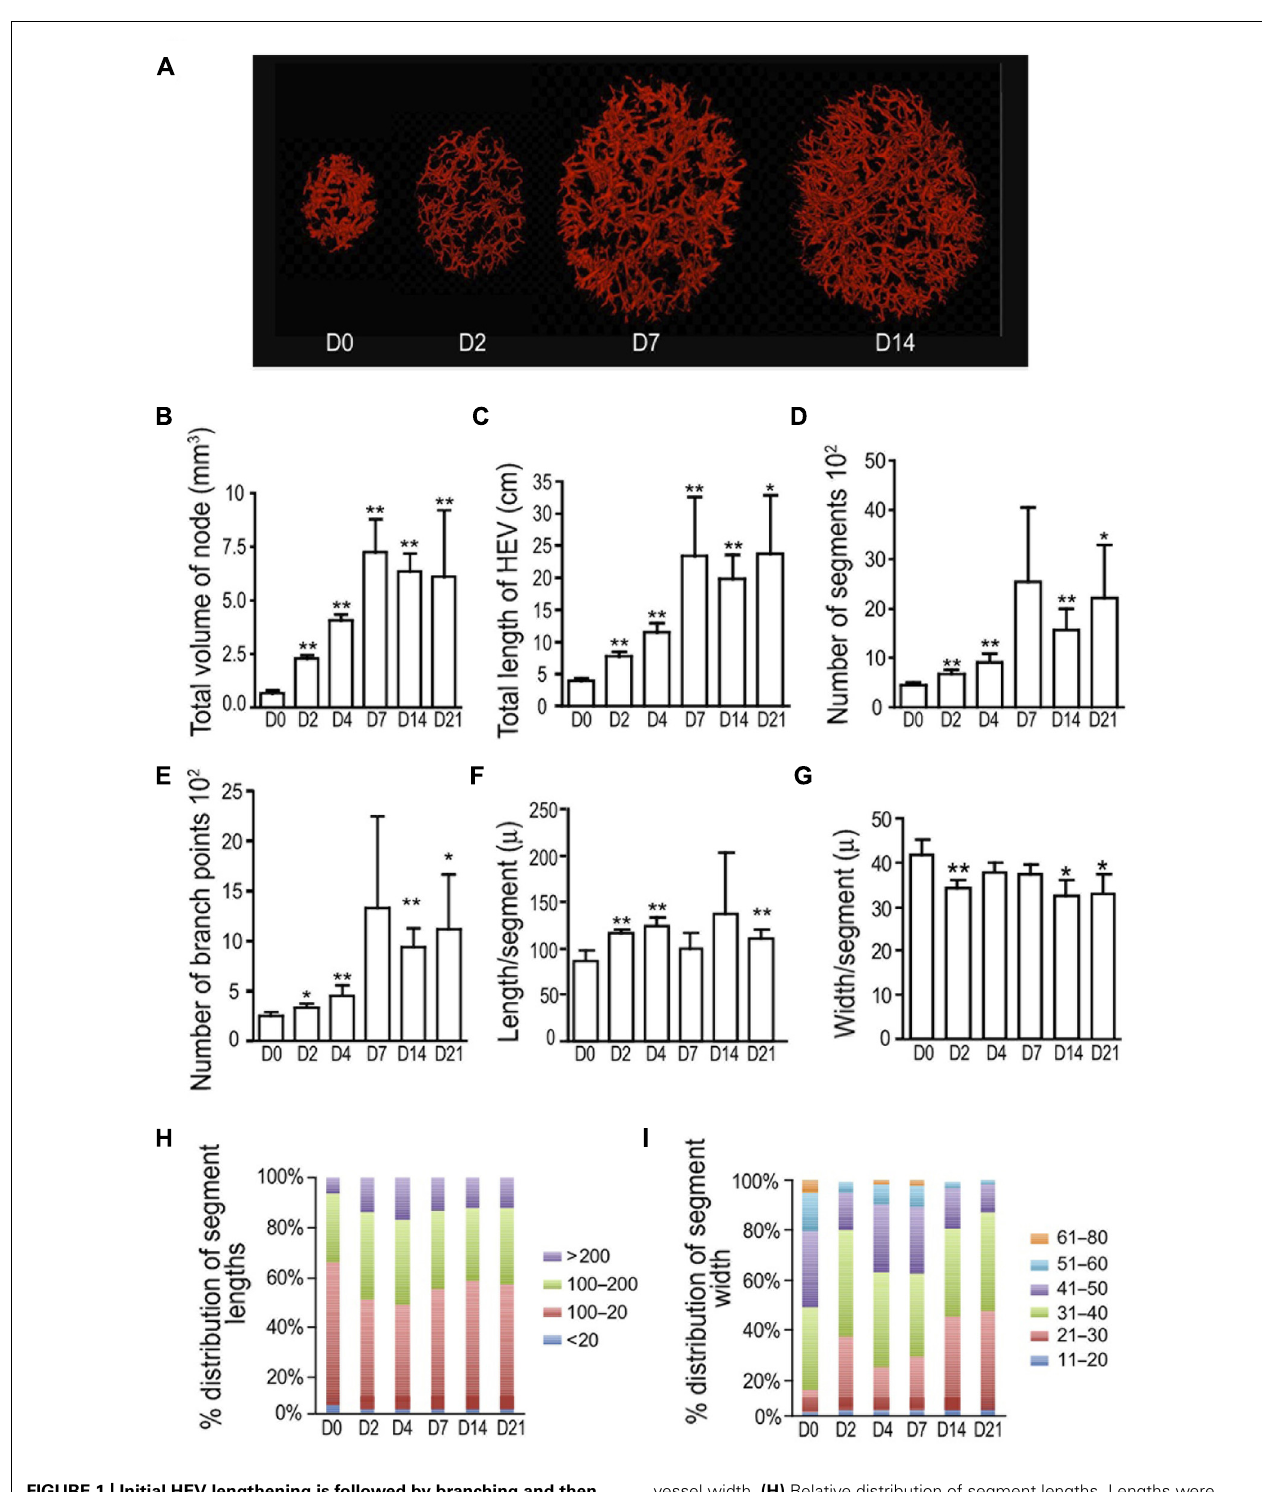
FIGURE 1 | Initial HEV lengthening is followed by branching and then narrowing after OVA/CFA. Mice were immunized in the footpad with OVA/CFA on day 0 and draining popliteal nodes were prepared for OPT imaging of PNAd + vessels on indicated days. (A) Representative images from OPT scanning. (B) Total lymph node volume. (C) Total length of HEV per lymph node. (D) Number of HEV segments per lymph node. (E) Number of branch points per lymph node. (F) Average segment length. (G) Average